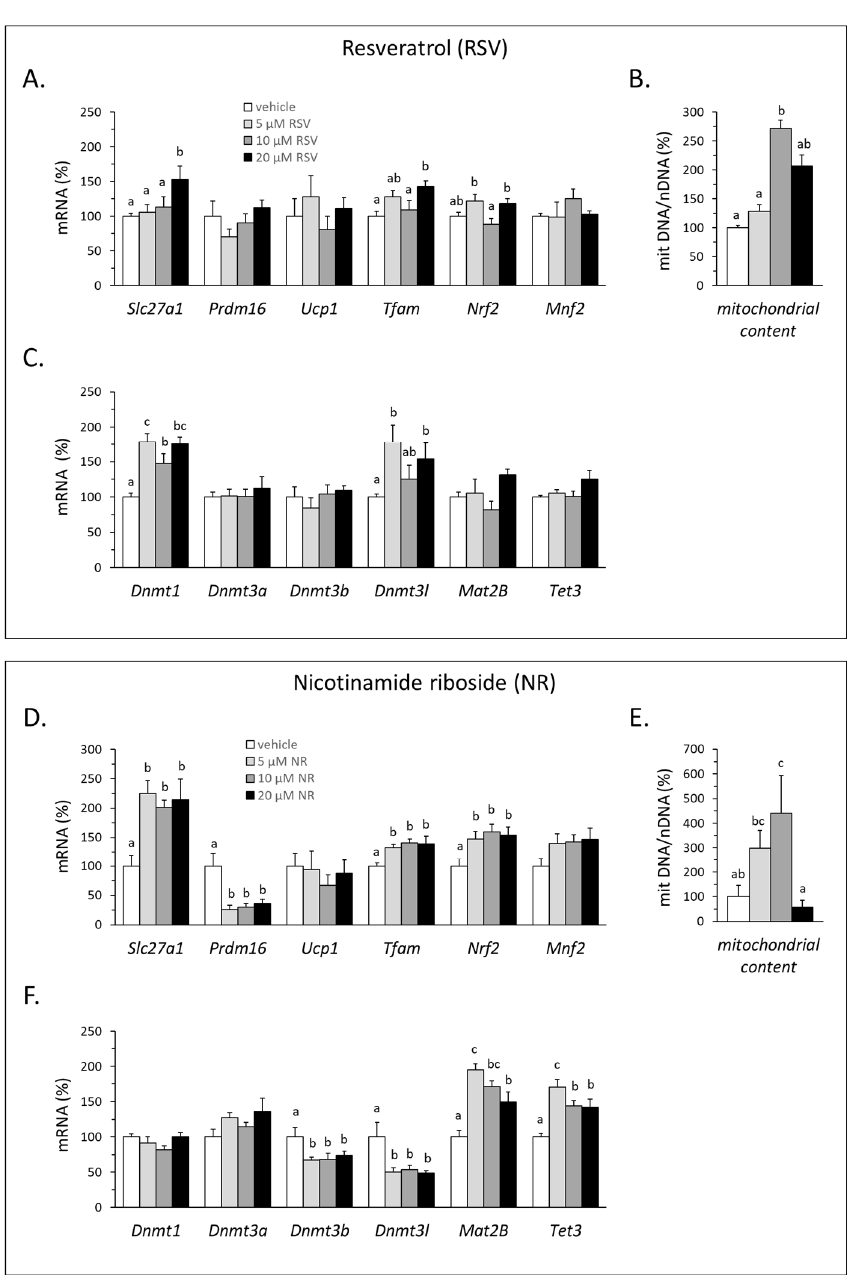
Figure 6. mRNA levels of indicated genes related to adipocyte browning ( A , D ), mitochondrial DNA to nuclear DNA ratio as an indicator of mitochondrial content ( B , E ), and mRNA levels of indicated genes related to the methylation machinery ( C , F ) in differentiated 3T3-L1 adipocytes exposed to the indicated agents and doses for 24 h. Data are expressed as mean ± SEM of n = 4 cultures per dose. Statistics: values not sharing a common letter are different with p < 0.05 according to ANOVA one-way, followed by LSD test.